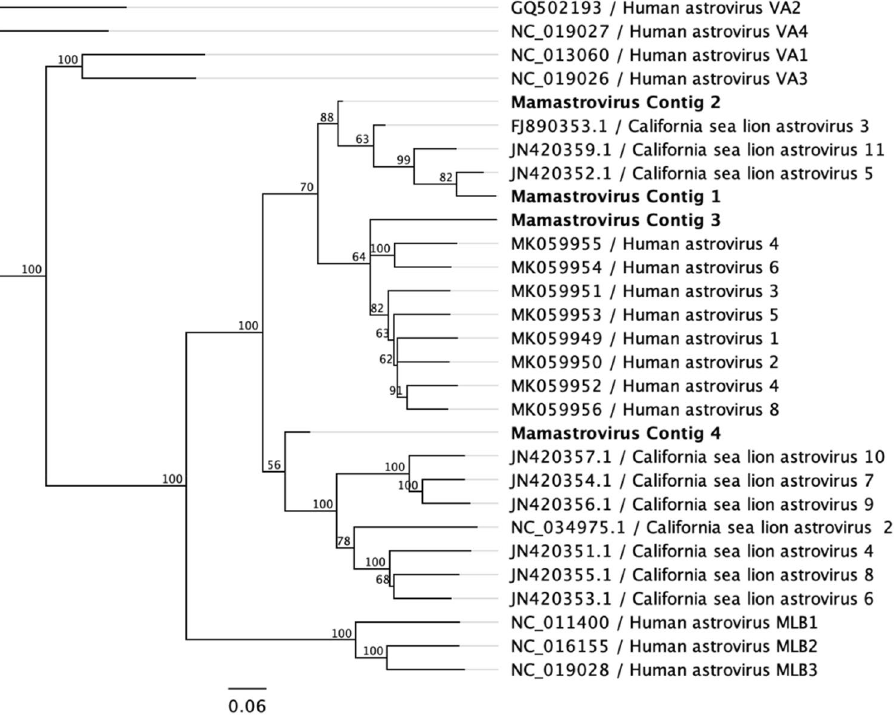
Figure 3. Phylogenetic consensus tree based on partial ORF2 sequences from the Mamastrovirus contigs sequenced from A. gazella scats (in bold). Bootstrap resampling with 1000